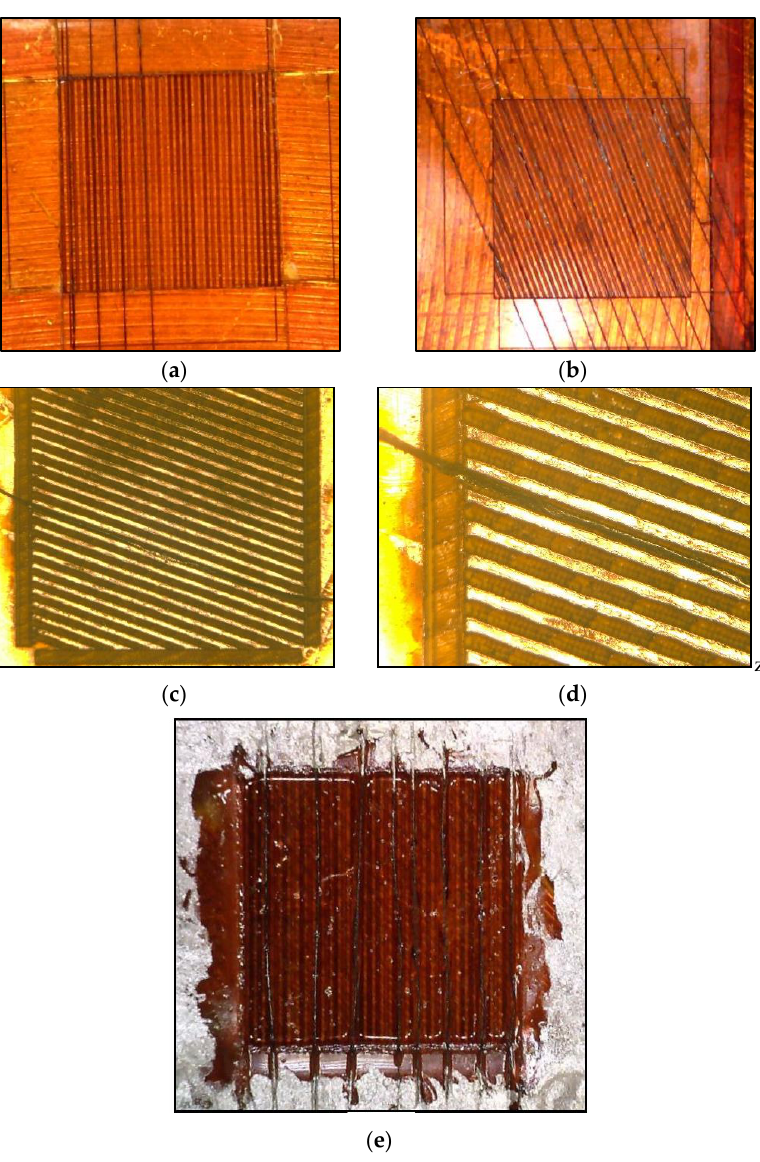
Figure 6. Optical images of the foil strain gauge prototypes: ( a ) Substrate with several CNT yarns placed in the grooves at 0°-inclination; ( b ) Substrate with several CNT yarns placed in the grooves at 70°-inclination. ( c ) Substrate with a CNT yarn placed in the groove; ( d ) Close-up of the substrate with a single CNT yarn placed in the groove; ( e ) Complete gauge showing CNT yarns in the grooves, adhesive layer on the gauge area, and conductive silver on the electrodes.